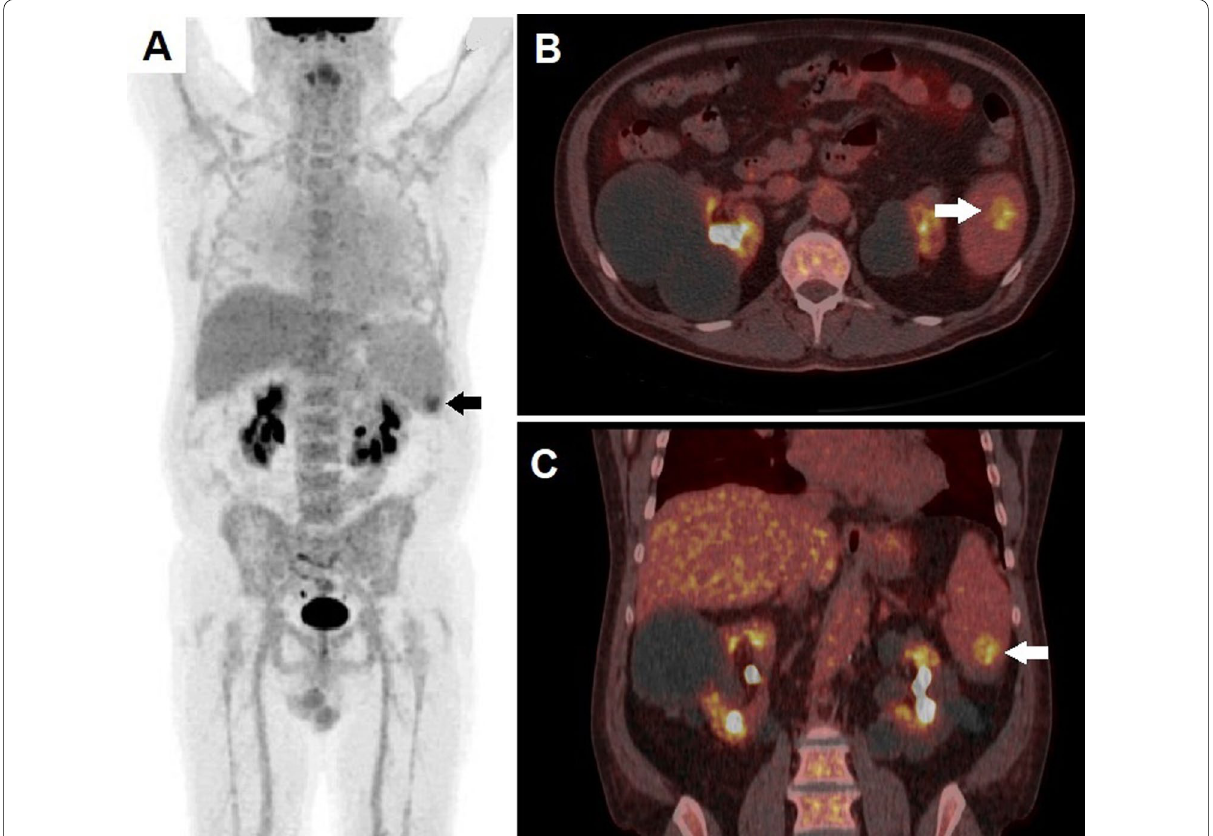
Fig. 1 18 F-FDG PET/CT Whole Body ( a ), performed at patient’s admission, demonstrated an area of increased tracer incorporation (SUVmax 6.1) in the spleen inferior pole (black arrow), associated with diffuse bone marrow uptake. Fused axial ( b ) and coronal ( c ) PET/CT slices well depicted focal 18 F-FDG accumulation (white arrow) within a hypodense area in the inferior splenic pole, with no evidence of meaningful spleen enlargement (splenic length 11